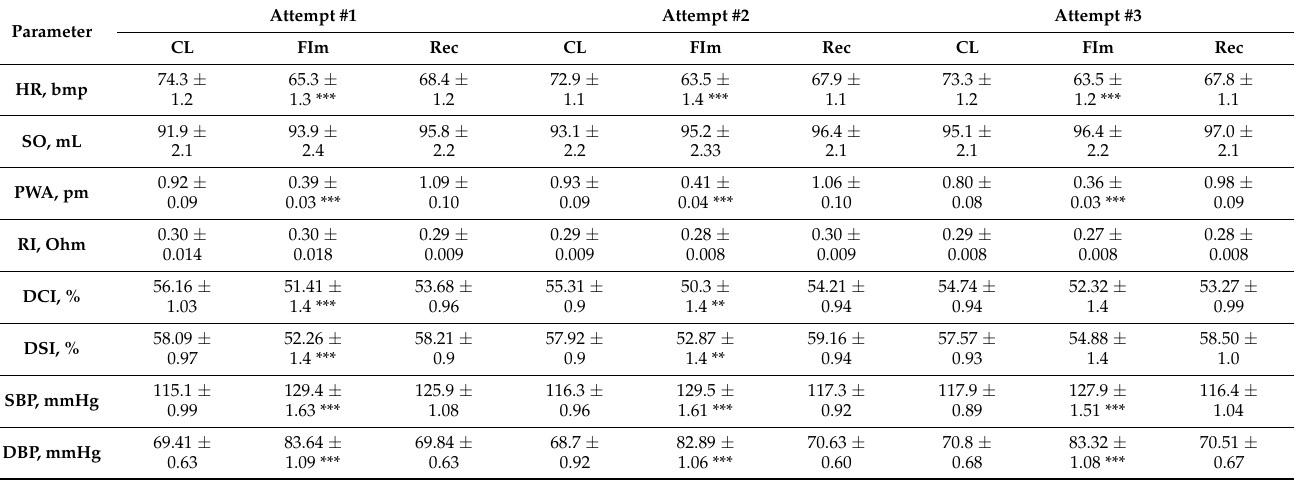
Table 2. Blood flow parameters from the subjects enrolled in the study before, during, and after the diving reflex